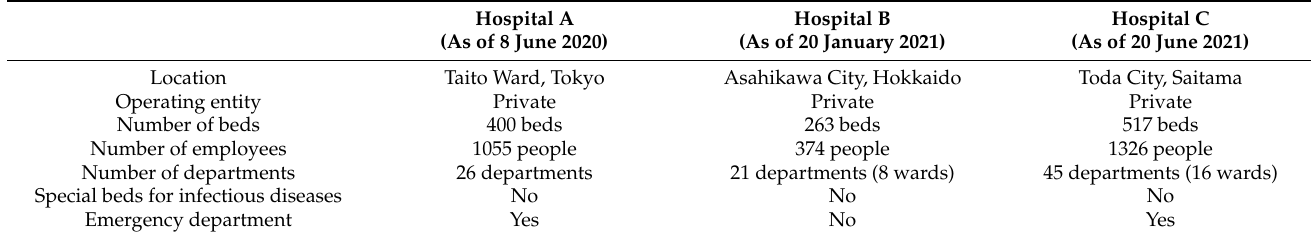
Table 1. Characteristics of three